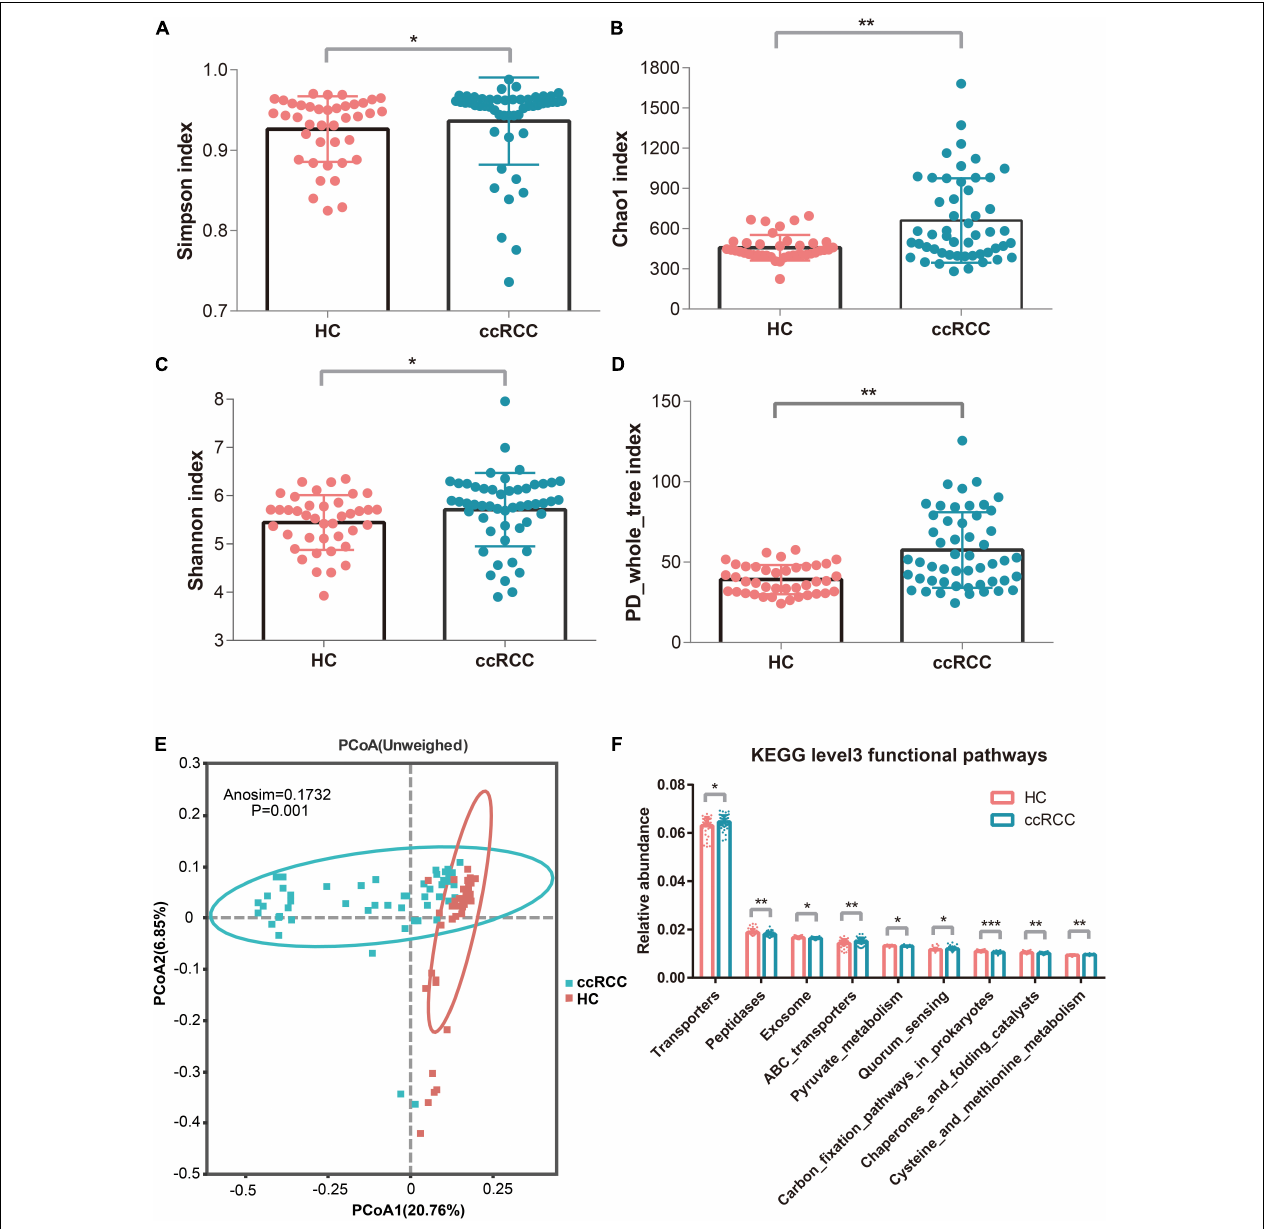
FIGURE 2 | Increased gut microbiota diversity and microbial functions in ccRCC group ( n = 51) vs. HC group ( n = 40). Alpha diversity, estimated by Simpson (A) , Chao1 (B) , Shannon (C) , and PD_whole_tree index (D) were significantly up-regulated in ccRCC group when compared with HC group ( p = 0.013, 0.0041,